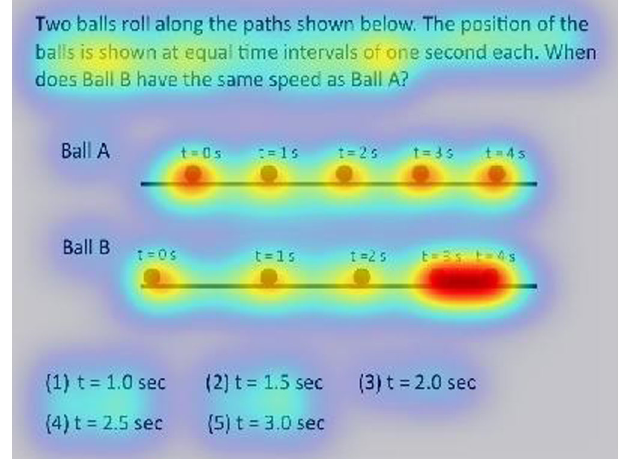
FIG. 1 (color online). Heat map of perceptual salience created using the Itti, Koch, and Niebur salience algorithm. Red indi- cates area of highest perceptual salience.